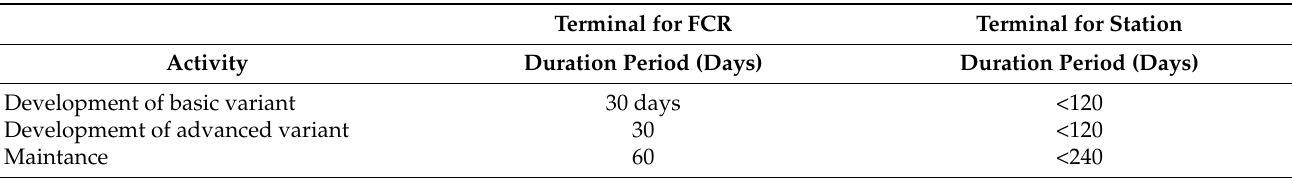
Table 4. The simulation of applying model-driven development method to the terminal for remote control of the station.